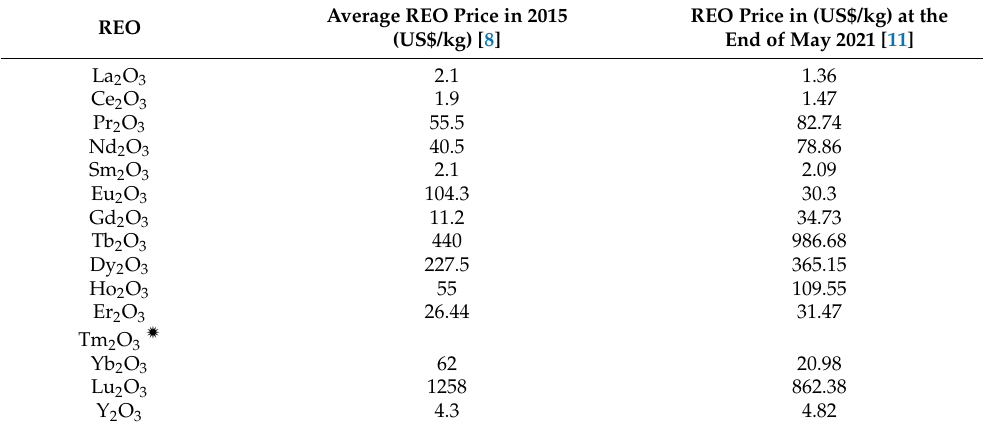
Table 2. Average rare earth oxide (REO) prices in the international market in 2015 [7] and REO prices in the international market at the end of May 2021 [10].